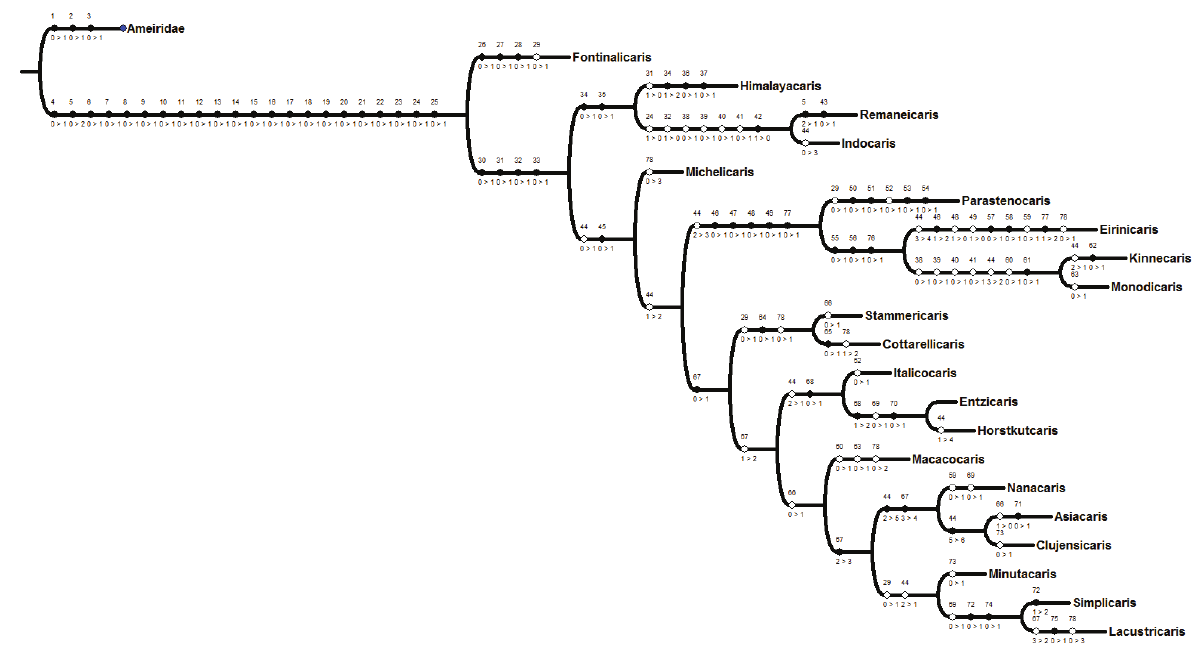
Figure 9. Phylogeny of the Parastenocaridinae reconstructed by applying Hennigian principles and criterion of putative parsimony based on the data matrix of Table 1. The cladogram was generated using the program NONA (Goloboff 1999) for cladistic parsi - mony, and in interface with WINCLADA (Nixon 2002). For details see Material and Methods. Characters as explained in the text; binary or multistate, polarized a priori; length of cladogram = 146. Circles represent autapomorphies, open circles represent autapo - morphies by reversion of character state. Direction of character transformation indicated below each